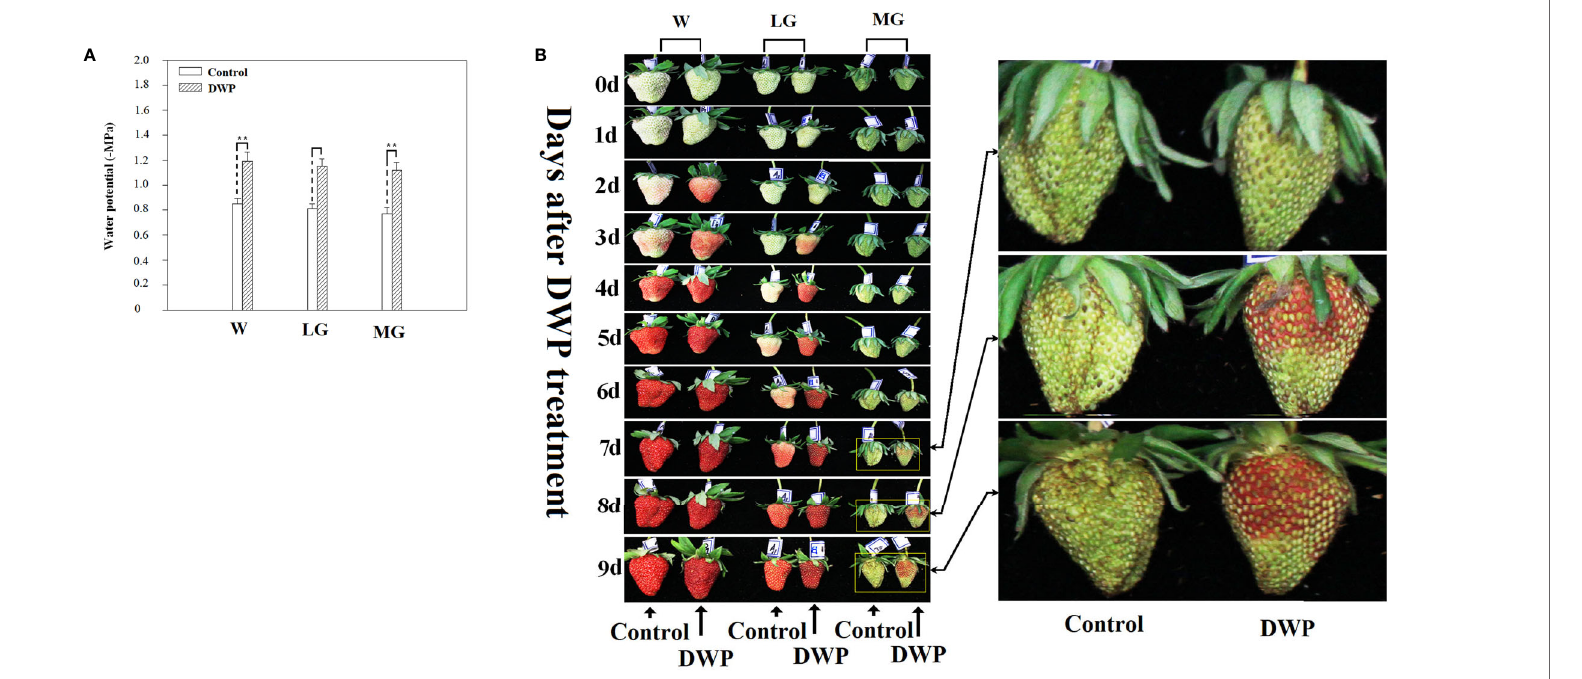
FIGURE 7 | Phenotypic observation of the effect of decrease in water potential (DWP) on fruit ripening. For DWP treatment, detached fruit were allowed to lose water under ambient conditions and fruit water potential was monitored at regular time intervals. Once fruit water potential had decreased to − 1.8~2.0 MPa, which is the approximate water potential of ripe fruits, fruit were maintained at 25°C under 100% humidity to prevent further decrease in water potential. Phenotypic changes were observed every day until fruits became red (~10 days). (A) Water potential as affected by water loss. (B) Phenotypic changes caused by DWP treatment. The right picture shows a magni fi cation of the phenotypic changes in the MG stage. W, white fruit; LG, large green fruit; MG, middle green fruit. Asterisks denote signi fi cant differences compared to the control at P < 0.01, according to a Student ’ s t